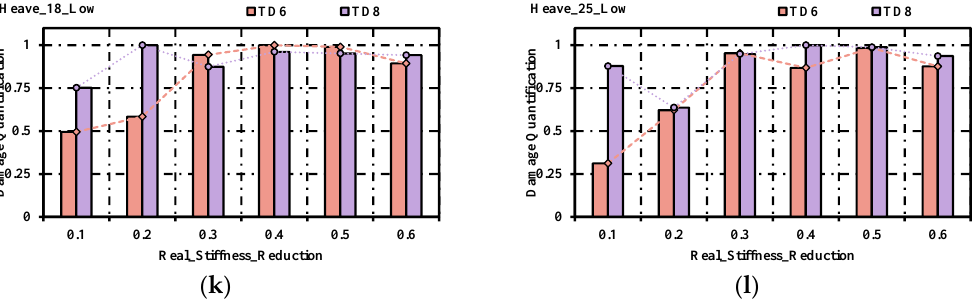
Figure 8. Damage quantification by Euclidean similarity. ( a ) Surge acceleration under 4 m/s, measured by the lower sensor. ( b ) Surge acceleration under 11.4 m/s, measured by the lower sensor. ( c ) Surge acceleration under 18 m/s, measured by the lower sensor. ( d ) Surge acceleration under 25 m/s, measured by the lower sensor. ( e ) Sway acceleration under 4 m/s, measured by the lower sensor. ( f ) Sway acceleration under 11.4 m/s, measured by the lower sensor. ( g ) Sway acceleration under 18 m/s, measured by the lower sensor. ( h ) Sway acceleration under 25 m/s, measured by the lower sensor. ( i ) Heave acceleration under 4 m/s, measured by the lower sensor. ( j ) Heave acceleration under 11.4 m/s, measured by the lower sensor. ( k ) Heave acceleration under 18 m/s, measured by the lower sensor. ( l ) Heave acceleration under 25 m/s, measured by the lower sensor.